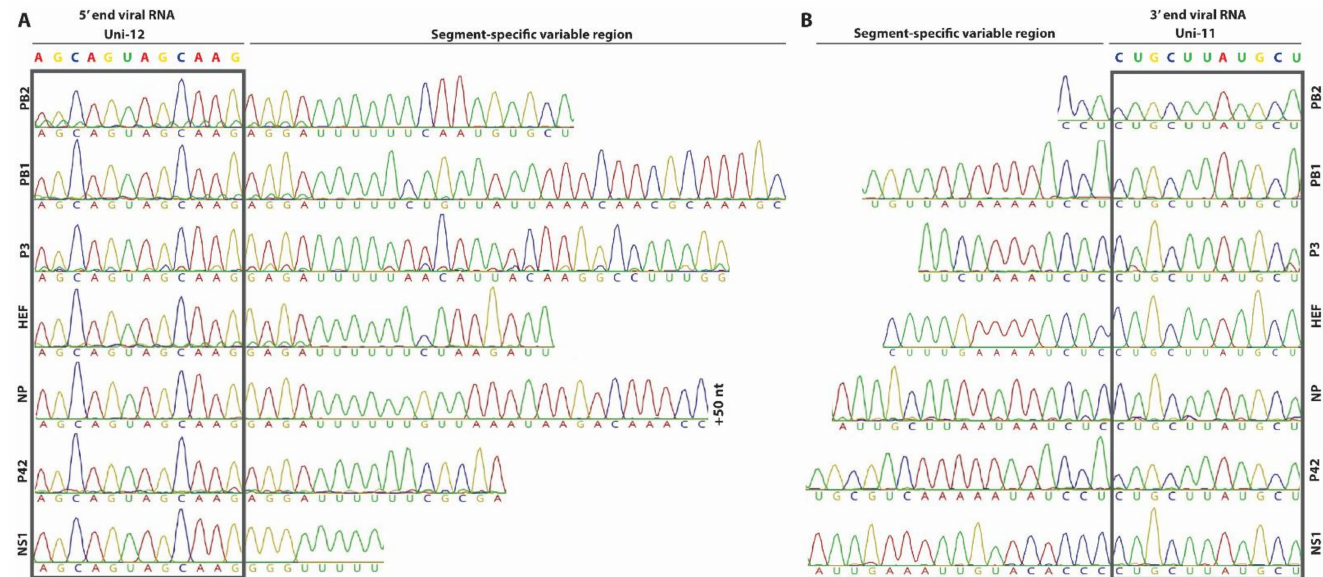
Figure 1. 5 (cid:48) and 3 (cid:48) RACE sequence results of the non-coding regions from the D/bovine/Switzerland/CN286 virus isolate. The 5 (cid:48) and 3 (cid:48) non-coding regions were determined via Sanger sequencing of 5 (cid:48) and 3 (cid:48) rapid amplification of cDNA ends (RACE) PCR amplified products. The conserved first 11 nucleotides (UCGUAUUCGUC) and the first 12 nucleotides (AGCAGUAGCAAG) of the 3 (cid:48) and 5 (cid:48) NCR, respectively, of the viral RNA are highlighted and adjacent to the segment-specific variable